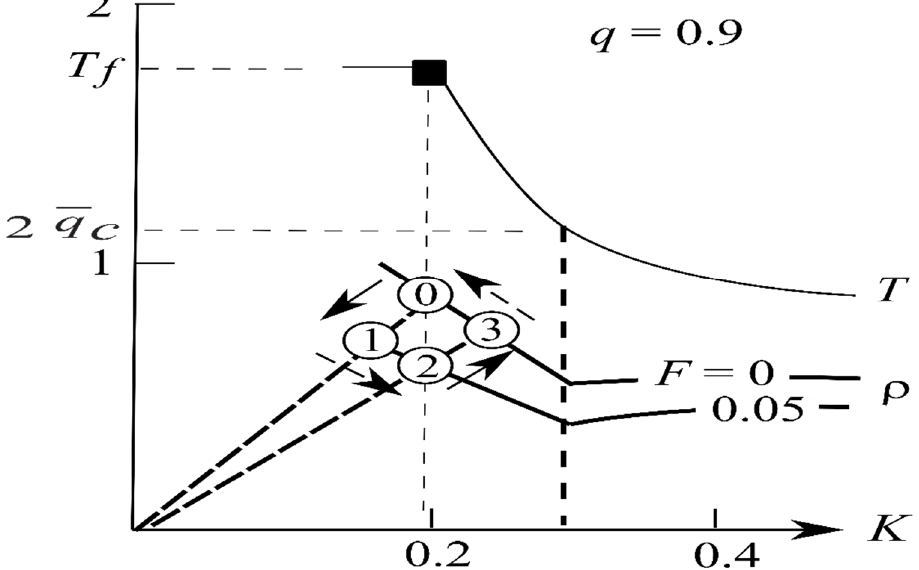
Figure 5. The H cycle in the phase-space when the freshwater flux ( F ) displaces the density curve (thick solid) and the MOC line (sloping dashed) pivots toward the MEP (solid rectangle) in response. The cycle goes through numbered states with solid and dashed arrows indicating abrupt decadal changes and the millennial MEP adjustments, respectively.